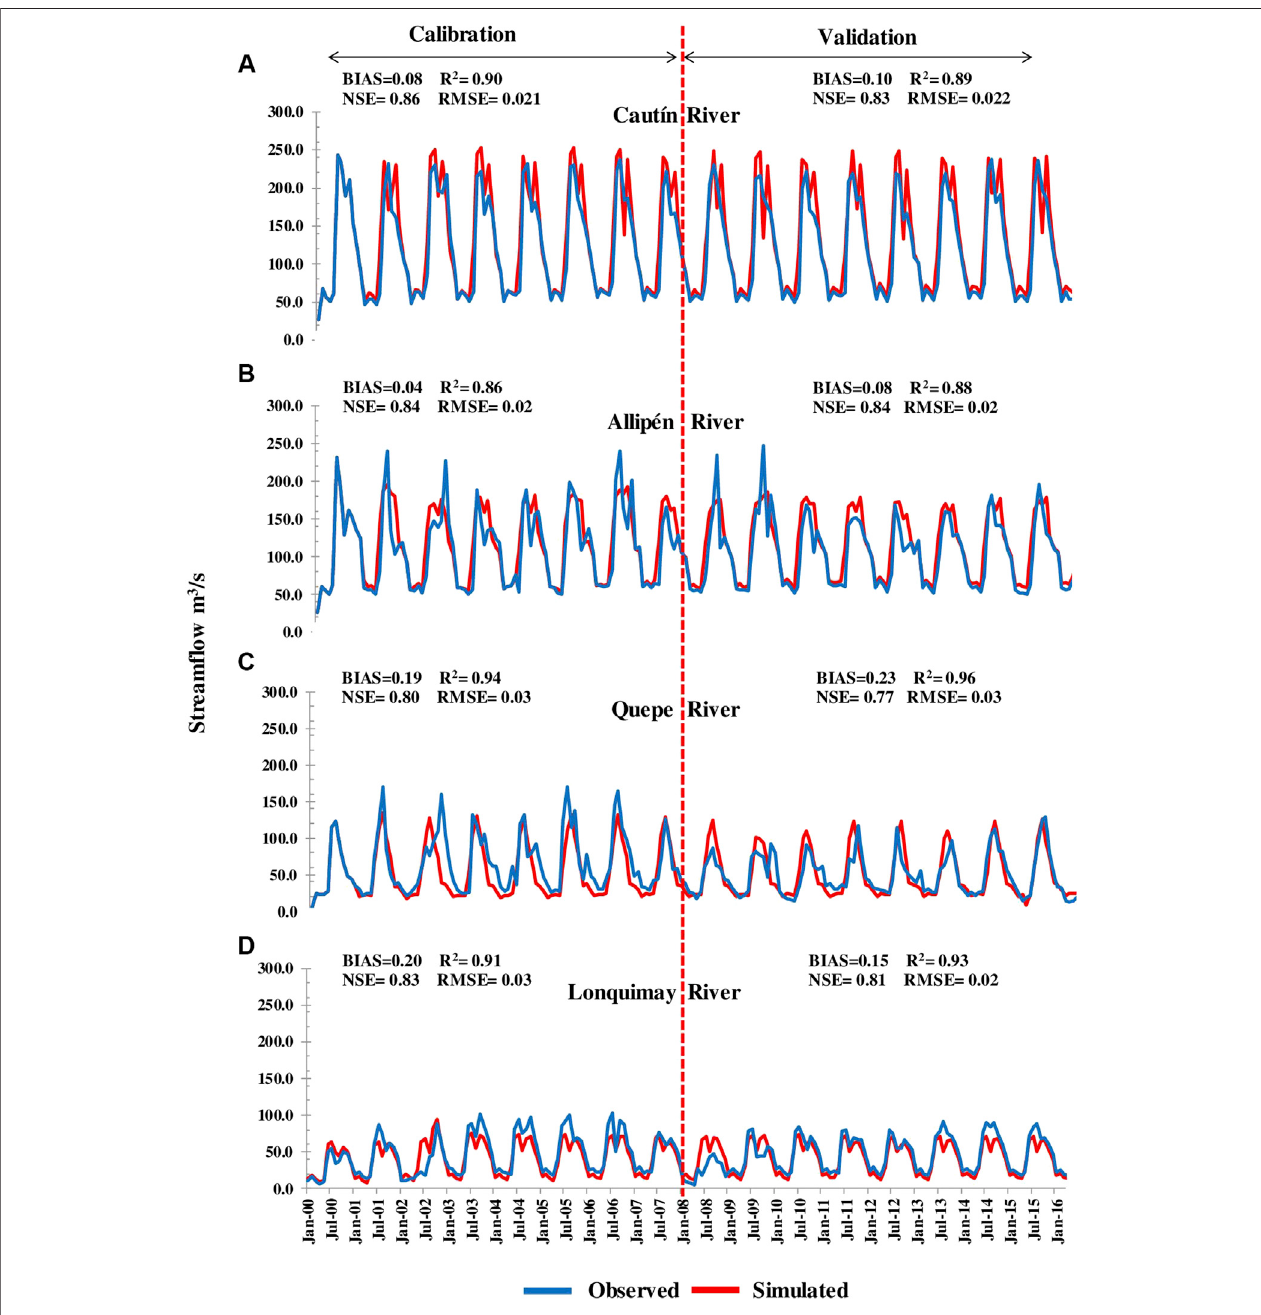
FIGURE3| Averagemonthlystream fl owtimeseries(m 3 /s)forthecalibrationandvalidationperiod,comparingobserved(blue)andWEAP-simulated (red)data. (A) SBC basin: Cautín river at the Rari-Ruca station. (B) SBA basin: Allipén river at the Melipeuco station. (C) SBQ basin: Quepe river at the Vilcún station. (D) SBL basin: Lonquimay river at the station located before its junction with the Bío-Bío river. For more details see also Table 2 .